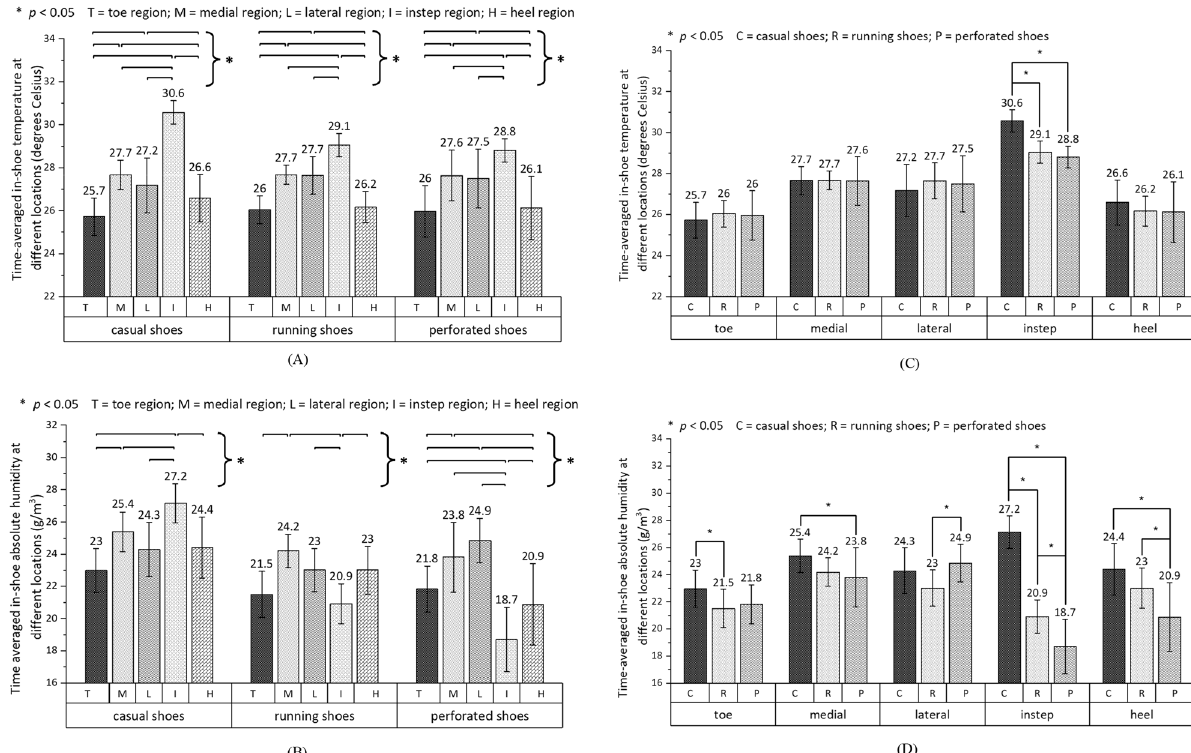
Figure 4. Time-averaged in-shoe temperature (mean ± SD) and absolute humidity (mean ± SD) at five footwear regions for three footwear types separately. (A,B) Compare the thermal characteristics between measuring regions, while (C,D) compare footwear types. Significant differences ( p < 0.05) between pairs of bars are indicated by an